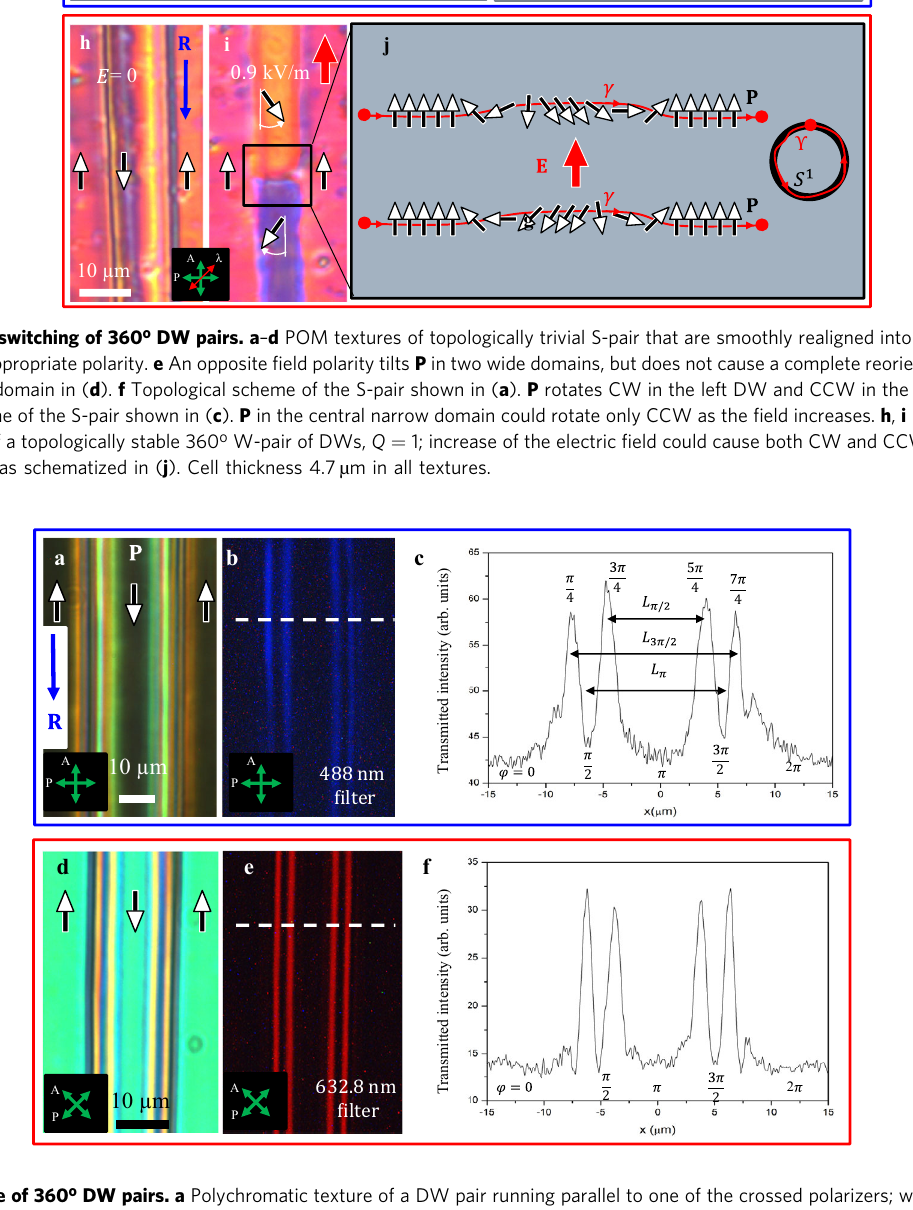
Fig. 4 Fine structure of 360 o DW pairs. a Polychromatic texture of a DW pair running parallel to one of the crossed polarizers; wide P ↑↓ R ( φ = 0, 2 π ) and narrow P ↓↓ R ( φ = π ) domains are extinct. b The same texture, observed with a blue fi lter; the stripes with φ = π /2 and 3 π /2 where P is perpendicular to the DWs are also extinct. c Transmitted light intensity along the dashed line in ( b ). d Polychromatic texture of a DW pair running at 45 o to the crossed polarizers; wide P ↑↓ R ( φ = 0, 2 π ) and narrow P ↓↓ R ( φ = π ) domains show similar optical retardance. e The same texture, observed with a red fi lter that yields destructive interference at locations φ = 0, π /2, π , 3 π /2, 2 π . f Transmitted light intensity along the dashed line in ( e ). Cell thickness 6.8 µ m in all textures.